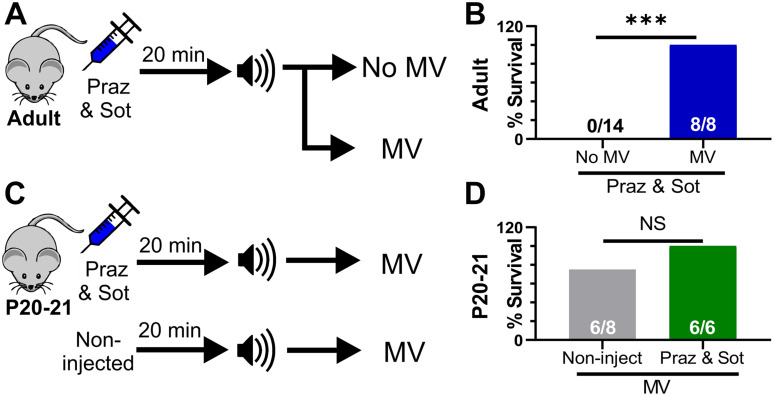
Mechanical ventilation does not require adrenergic receptor function to prevent seizure-induced sudden death. (A) Adult mice were injected (i.p.) with prazosin (1 mg/kg) and sotalol (10 mg/kg) 15 min before simulation of an audiogenic seizure. Some mice were either mechanical ventilated (MV) or not (No MV). (B) MV increased survival (8 of 8 adult D/+ mice) compared to No MV (***P < 0.001). (C) P20-21 D/+ mice were either non-injected or injected with a combination of prazosin (1 mg/kg) and sotalol (10 mg/kg) 15 min prior to stimulation of an audiogenic seizure. All mice received mechanical ventilation (MV). (D) 6 of 8 P20-21 D/+ mice that received MV only survived and were not statistically different from mice injected with a combination of prazosin (1 mg/kg) and sotalol (10 mg/kg) 15 min prior to stimulation of an audiogenic seizure that also received MV (6 of 6 mice). Statistical comparisons were made using one-sided Fisher’s exact tests.